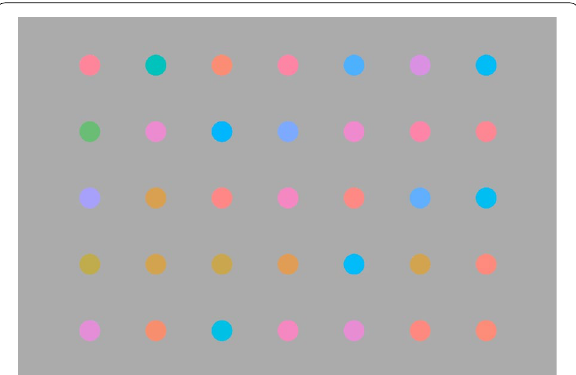
Fig. 1 Sample search display in Experiment 1. Note In Experiment 1, each search item was a circle filled with a changing color. When an item changed to green (e.g., the left-most item in the second row), it became a target, and the participant had to detect it (online demo available at: https:// louis khchan. github. io/ dynam ic_ search_